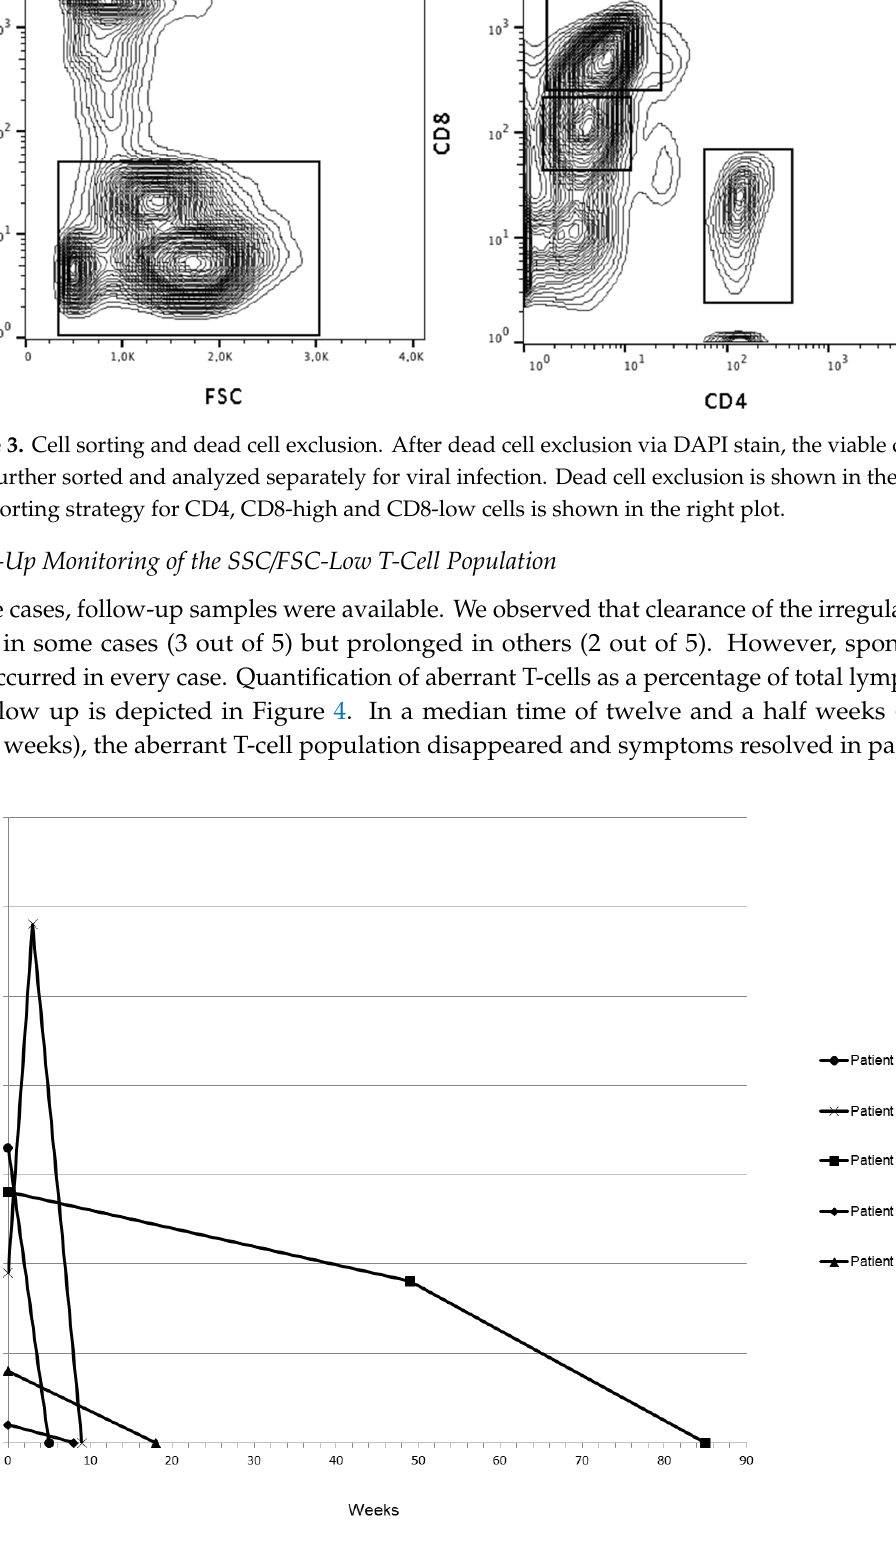
Figure 2. Clonal V beta T-cell receptor expansion on the aberrant cell population . In each row, gating on lymphocytes and CD3-positive cells (colored black) is shown (left and middle). On the right, analysis of Vß TCR of the CD3-positive cells is depicted. In row C, Vß TCR in Vß20/Vß5.1 versus Vß18/Vß5.1 is shown on the right. Monoclonal expression of Vß18 is clearly visible (colored red).